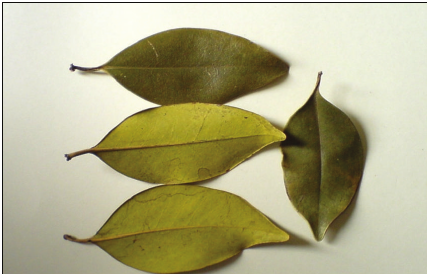
Figure 2: T.S. of leaf showing midrib and lamina (4x).